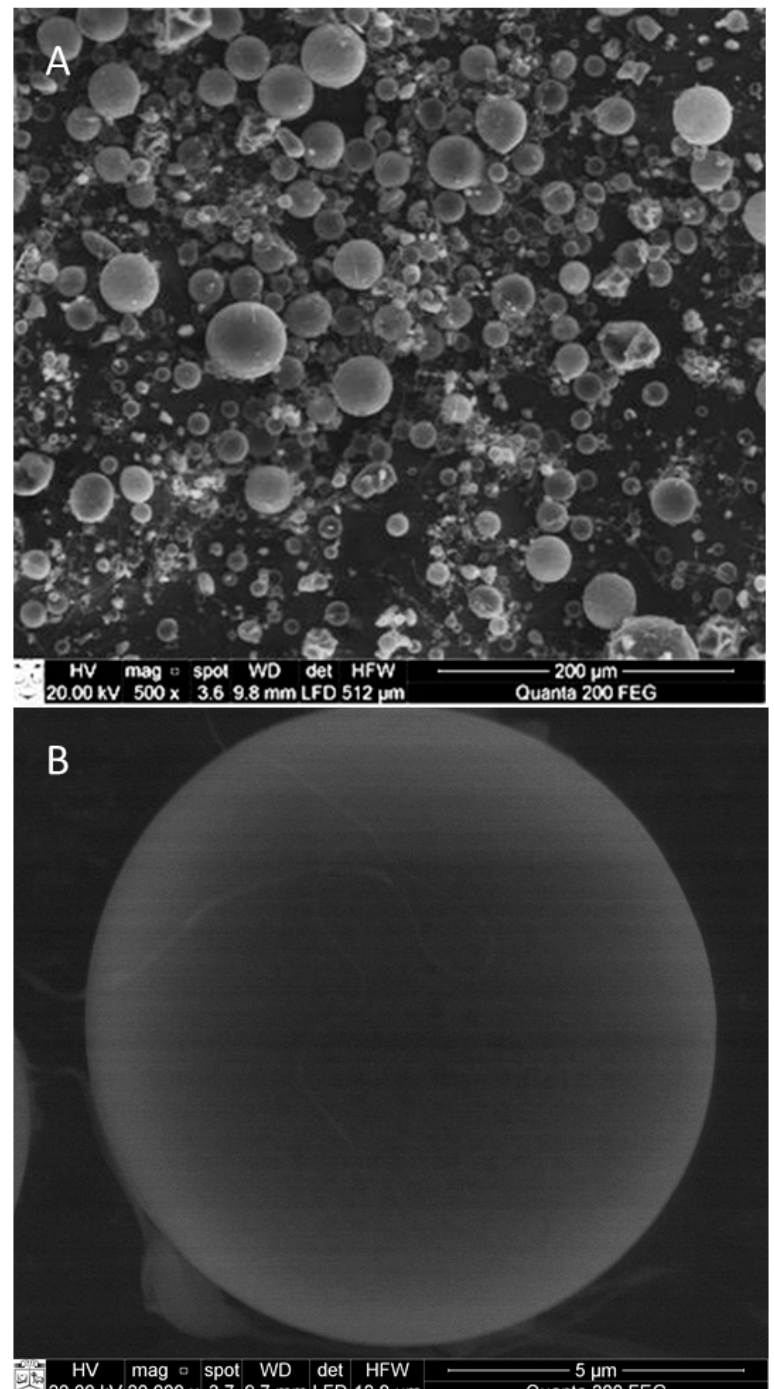
Figure 5. Scanning electron microscopy (SEM) of oregano microcapsules at lower ( A ) and higher ( B ) resolution. Microcapsule formulation: wall material (10 g of gelatin, 7.5 g of gum Arabic, 1.99 g of Tween 20, 1.98 g of β -cyclodextrin) and 20 g of ethanolic oregano extract as the core. Spray-drying parameters: The inlet temperature—170 ° C, feed flow rate—40 mL/min, concentration of wall material in solution—20%.